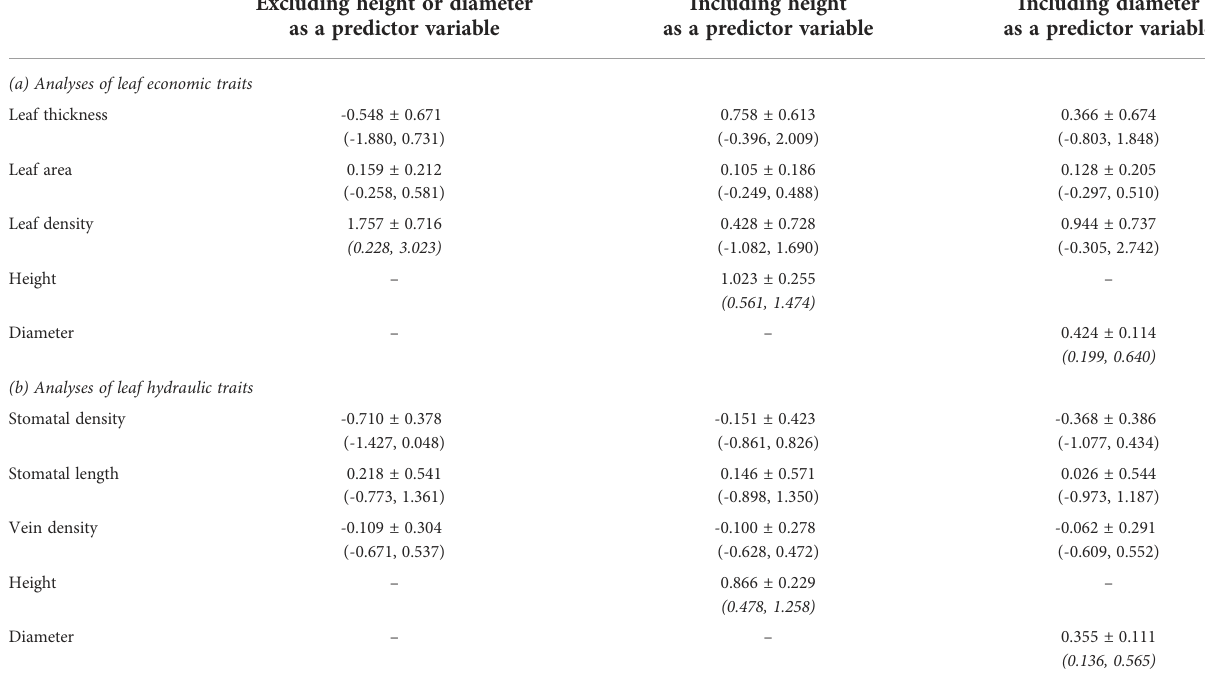
TABLE 4 Relationship of tree survival with leaf economic and hydraulic traits, and excluding or including the modelling of growth performance measures (height or diameter), assessed in a common-garden fi eld trial of E. pauci fl ora . Excluding height or diameter Including height Including diameter as a predictor variable as a predictor variable as a predictor variable